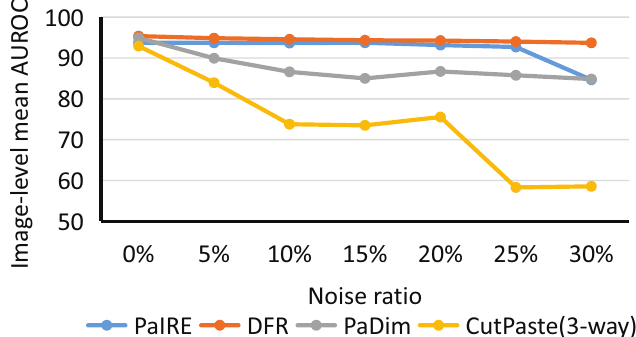
Figure 11. Comparison on BTAD